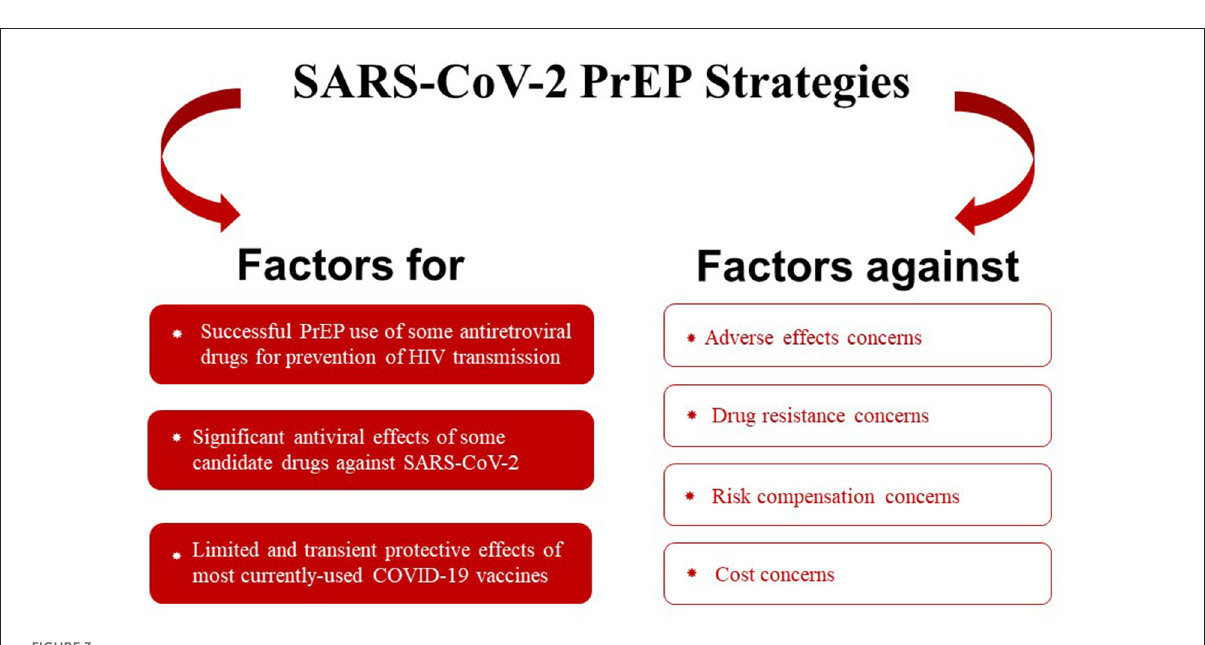
FIGURE3 Pros and cons of SARS-CoV-2 PrEP